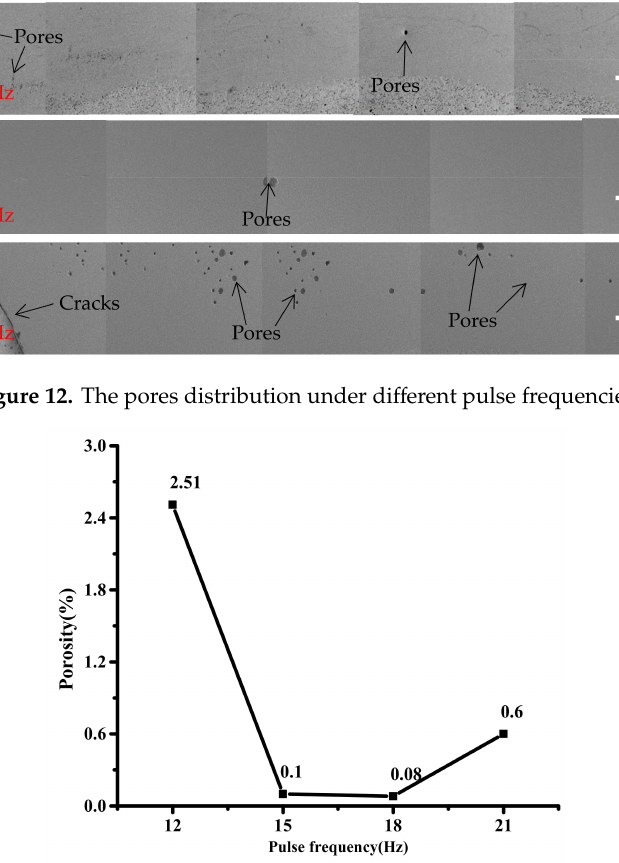
Figure 13. The porosity variation curve of the sealing layer under di ff erent pulse